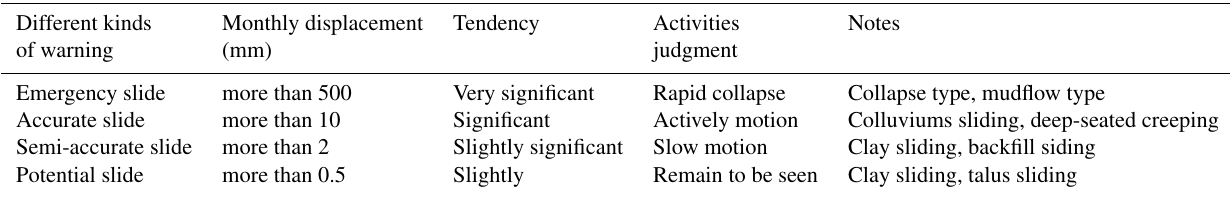
Table 3. Different warning conditions of a landslide (JASDiM, 1978). Different kinds Monthly displacement Tendency Activities of warning (mm) Emergency slide more than 500 Very significant Rapid collapse Accurate slide more than 10 Potential